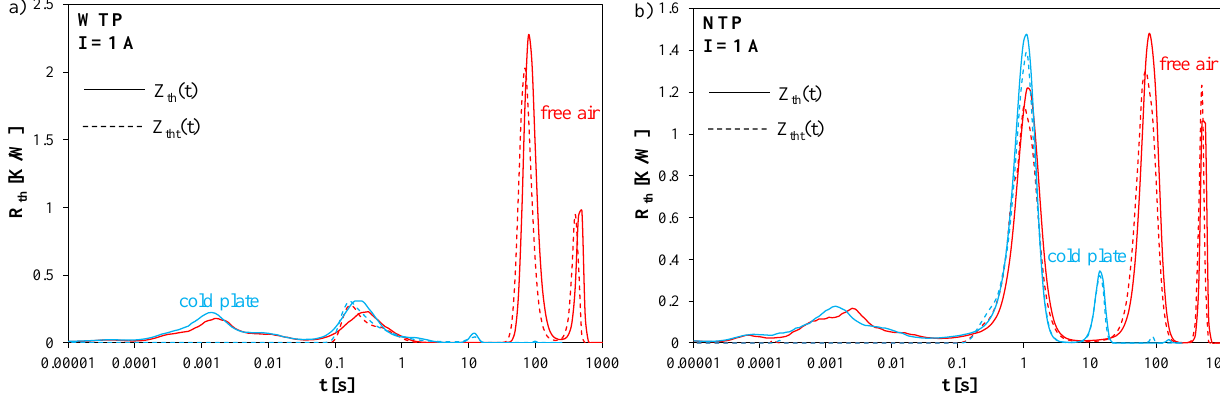
Figure 10. Spectra of thermal time constants determined using the MASTER software on the basis of the measured waveforms of self (solid lines) and transfer (dashed lines) transient thermal impedances of the dies contained in the MCE device WTP ( a ) and NTP ( b ) measured by the T3Ster set-up.